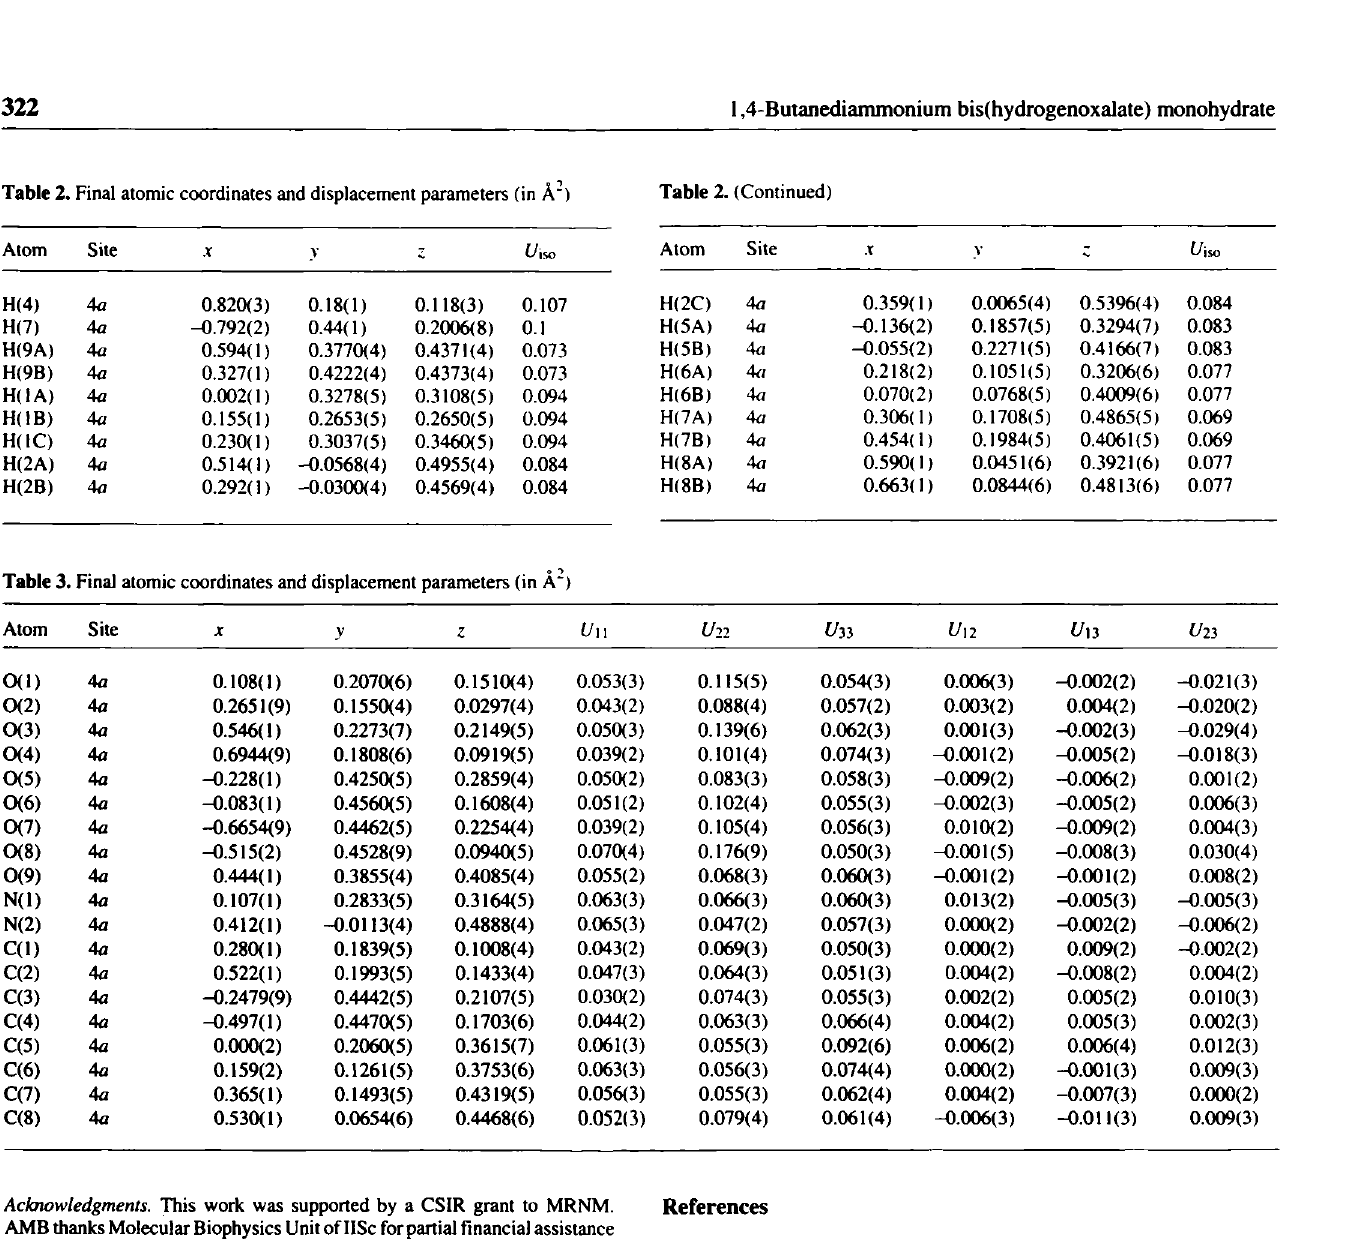
Table 2. Final atomic coordinates and displacement parameters (in Λ")